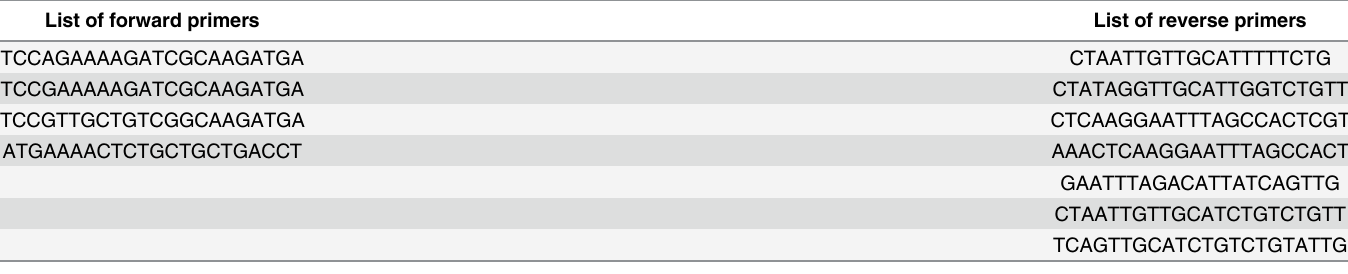
final volume of 50 μ L. PCR experiments were performed using a Techne TC-512 thermal cycler. Touchdown PCR conditions were as follows: Initial denaturation at 94°C for 3 min. Denaturing at 94°C, 30 sec; annealing temperature gradient 66 – 50°C, 1 min (-1.6°C/cycle); extension at 72°C, 1 min; 10 cycles. Denaturing at 94°C, 30 sec; annealing at 50°C, 1 min; exten- sion at 72°C, 1 min; 25 cycles. Final extension at 72°C for 10 min. Amplicons were visualised on a 1% agarose in TBE gel, and analysed using the Bio-Rad Gel Doc System and Image Lab Software (Bio-Rad). Table 2. Elapid three-finger toxin PCR